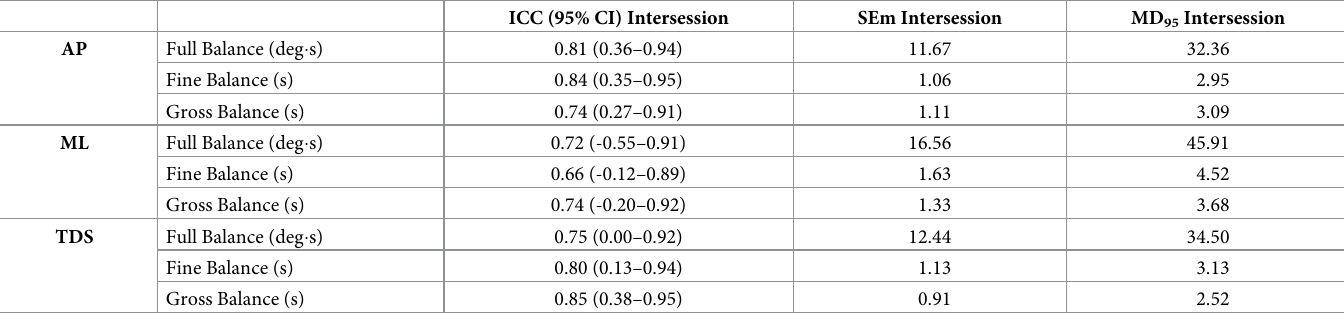
Table 5. Average intersession [3,1] intraclass correlation coefficient (ICC) and 95% Confidence Intervals (95% CI), Standard Error of the measurement (SEm), and Minimal Detectable Change (MD 95 ) calculated during the performances on the unstable